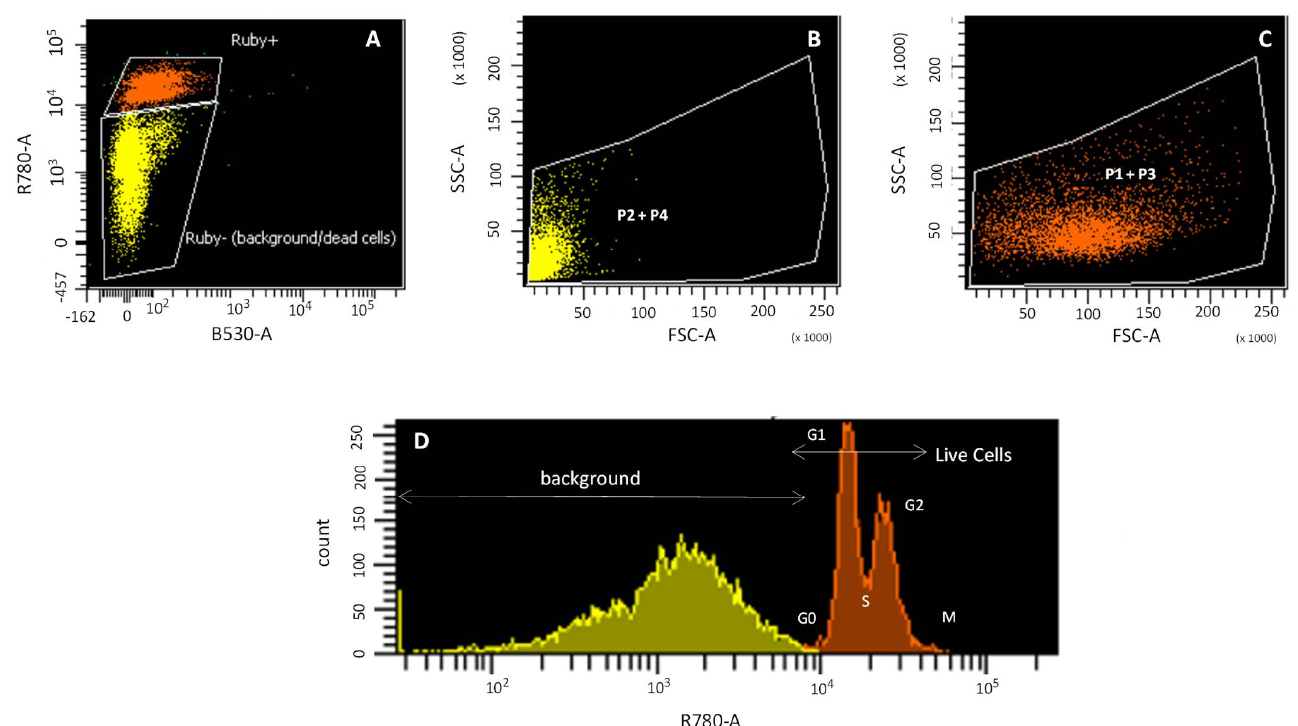
Figure 2. Cell cycle study by flow cytometry. Ruby (R780-A) signal (Ruby+ orange and Ruby-yellow) ( A ); cell size (FSC) vs. cellular complexity (SSC) of P2 + P4 populations ( B ); cell size (FSC) vs. cellular complexity (SSC) of P1 + P3 populations ( C ); Histogram of Ruby fluorescence signal ( D ).